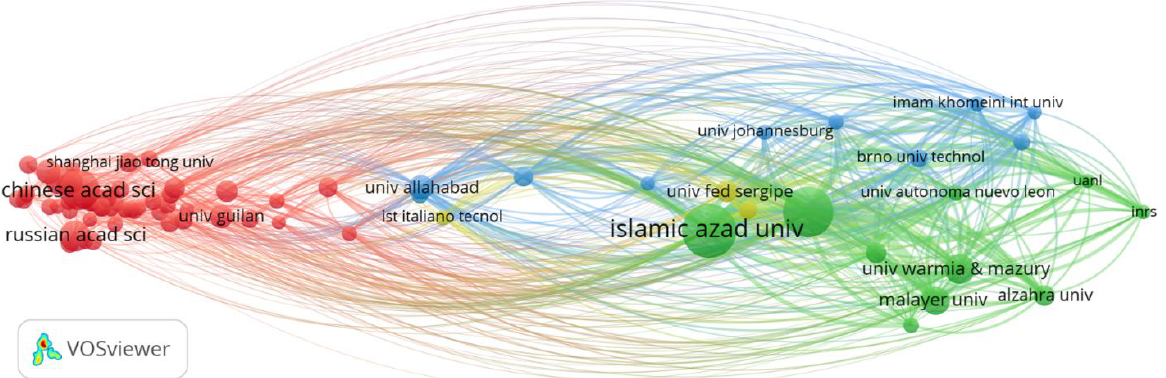
Figure 9. A map of bibliographic coupling of institutions publishing in fractal theory and thin films. A threshold of 5 documents and 50 citations per institution.